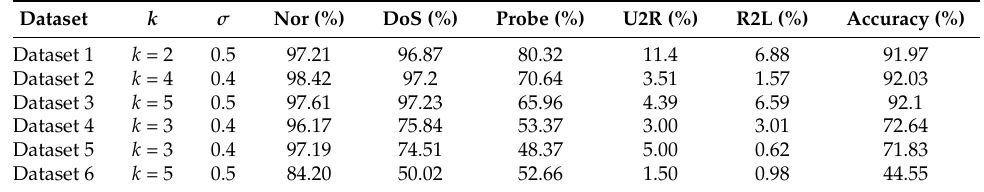
Figure 4. ( a–f ) Comparing SCDNN accuracy for different numbers of clusters k for the six datasets. Table 2. Detection accuracy of five attack types using the optimal number of clusters for each